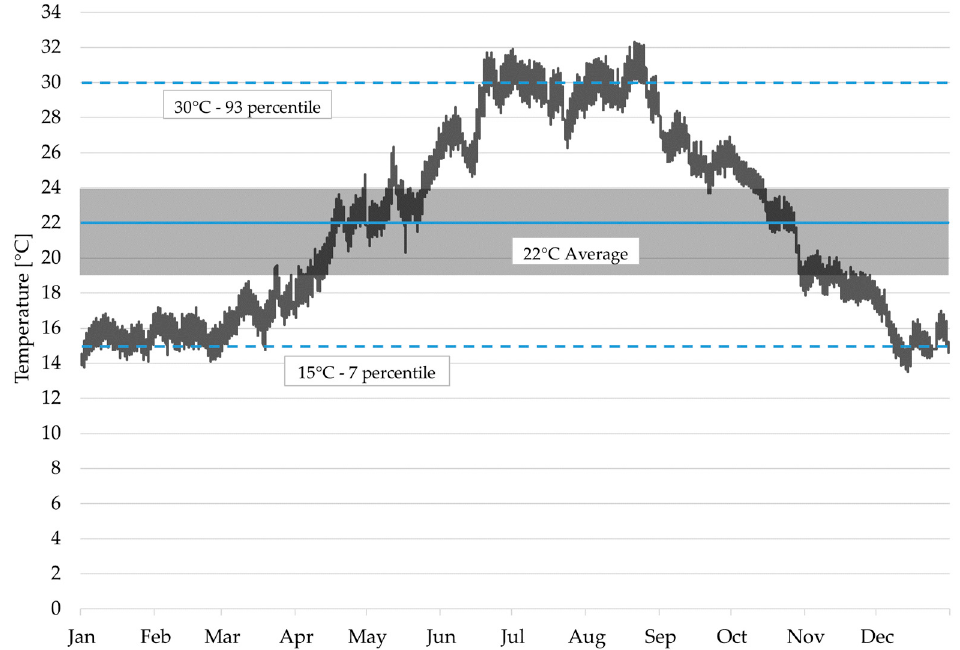
Figure 23. Trend of historic climate hourly values of T and statistical limits of 93rd and seventh percentiles in room XXII vs. the range recommended by the Italian D.M. 10.05.2001 [16] (gray band).